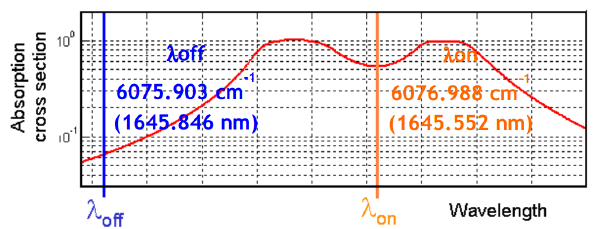
Figure 1. Laser frequency positioning of the online and offline laser beams. The online frequency is positioned in the trough of one of the methane absorption line multiplets. The offline frequency is po- sitioned so that the methane absorption is negligible.